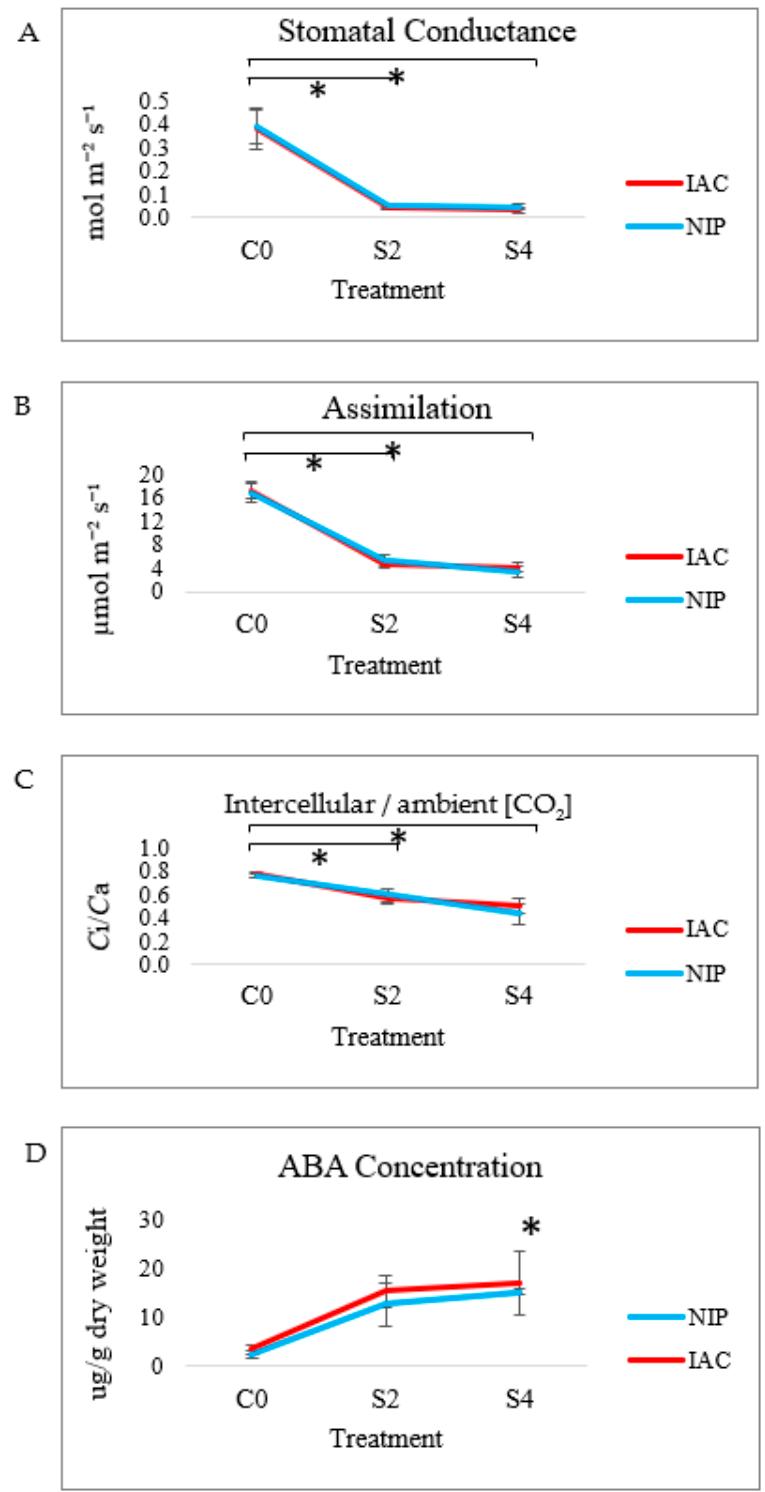
Figure 1. Photosynthetic responses and ABA content of Nipponbare and IAC1131 in response to multiple abiotic stress at three time points (0d = C0, 2d stress = S2 and 4d stress = S4). ( A ) Assimilation (Ar), ( B ) stomatal conductance (gs) ( C ) ratio of intracellular to ambient CO2 concentration (Ca/Ci) and ( D ) ABA concentration. Standard errors were obtained from three biological replicate measurements. An asterisk (*) indicates statistically significant difference between the control and stress conditions, according to Student’s t -test ( p -value < 0.05).